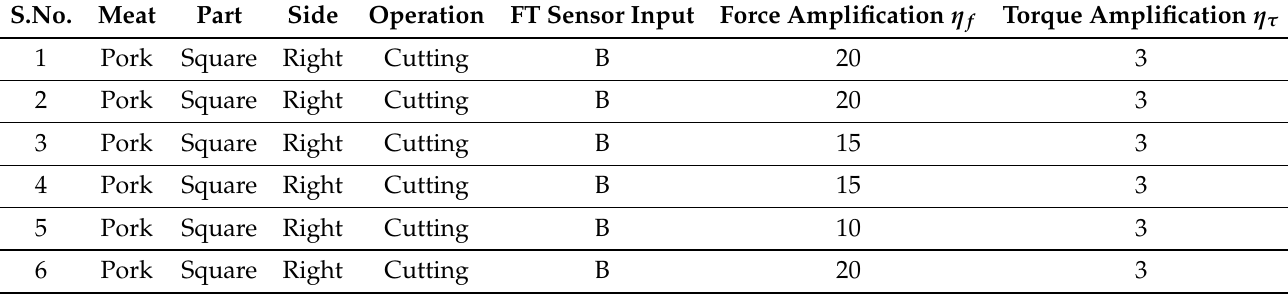
Figure 16. Iterative procedure for tuning the two amplification factors for forces and torques. Table 6. Determining the force amplification factor η F